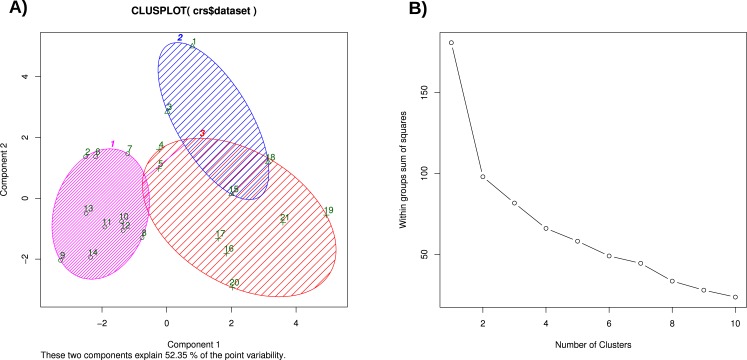
(A) K-Means clustering of the normalized chicken data set, considering three clusters, (B) SSE plot for estimating the cluster number.